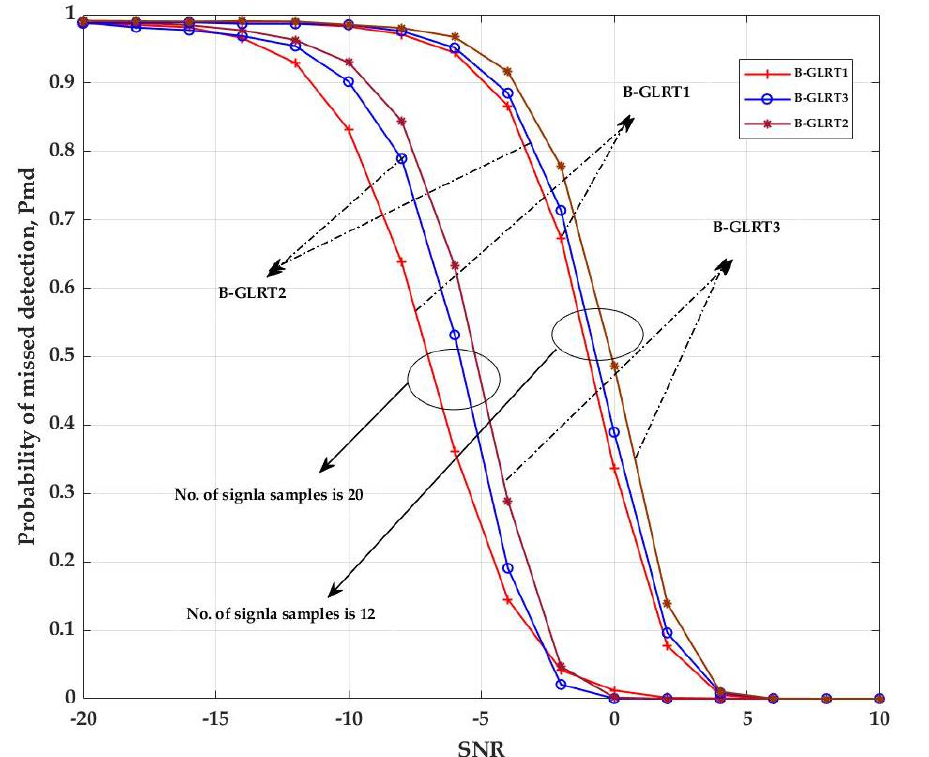
Figure 8. Probability of missed detection for the detectors versus a SNR with Pf a = 5 × 10 − 1 , N r = 3, N t =